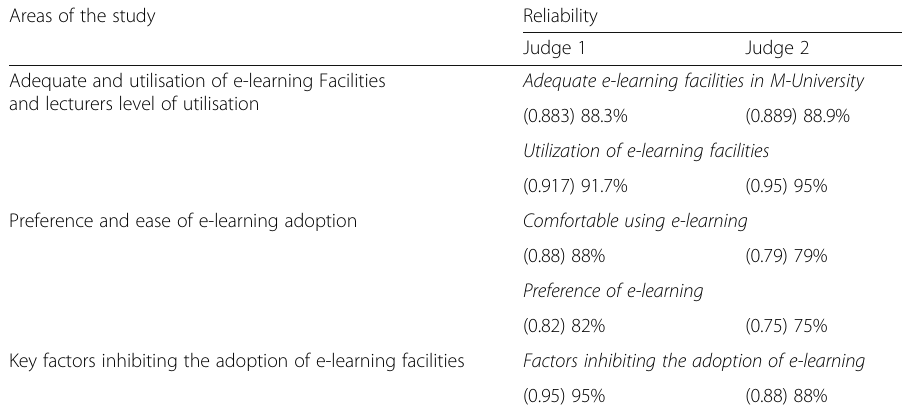
Table 5 Reliability